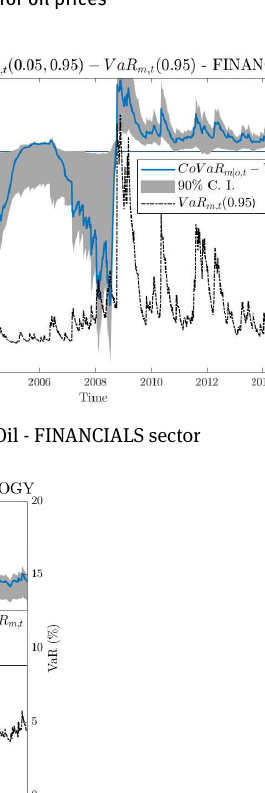
Figure 17c: CoVaR m | o , t (0.05, 0.95) for a certain sector given a bullish scenario for oil